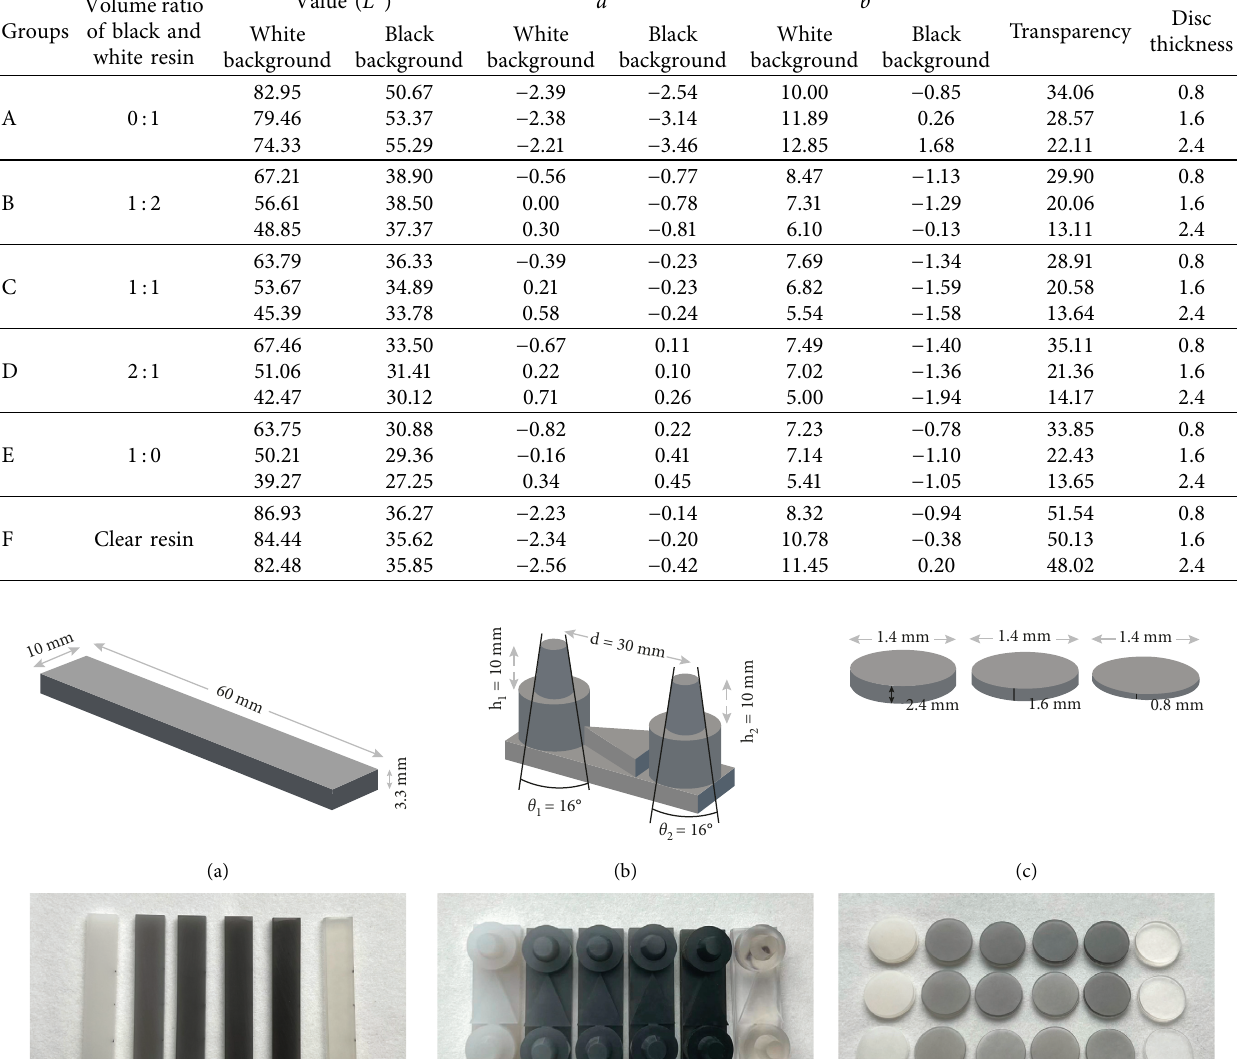
Table 1: Groups with resins of different